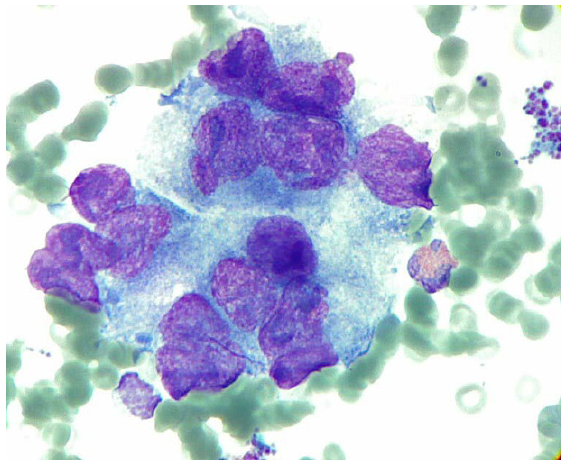
Figure 3. May-Grünwald-Giemsa stain of bone marrow aspirate smears (x1000). The centrally placed large cell conglomerate consists of adenocarcinoma cells with ample basophilic cytoplasm and irregular nuclei. A single eosinophil is present